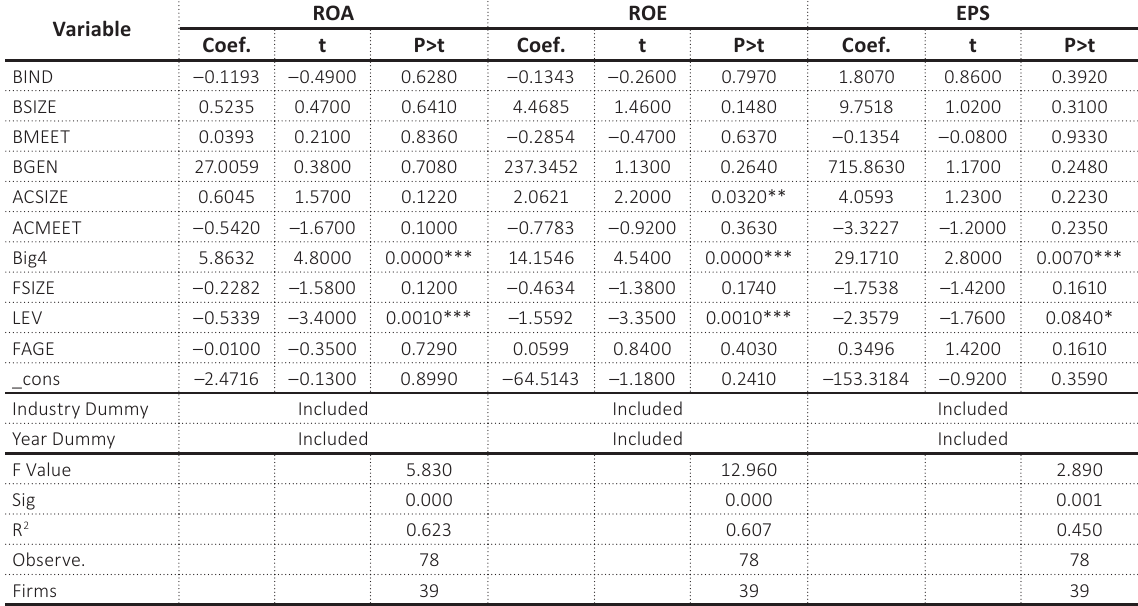
Table 7. OLS regression for the three models